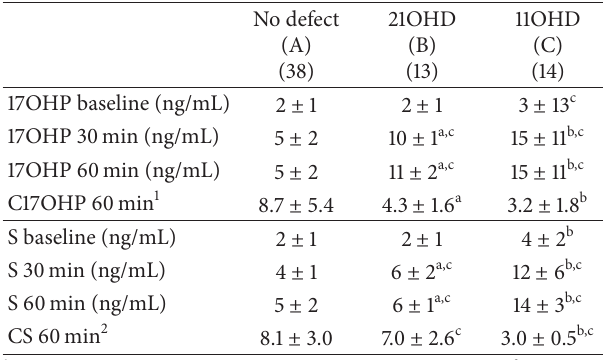
Table 2: Steroidogenesis in patients with no defect (A) or with the 21OHD (B) or 11OHD